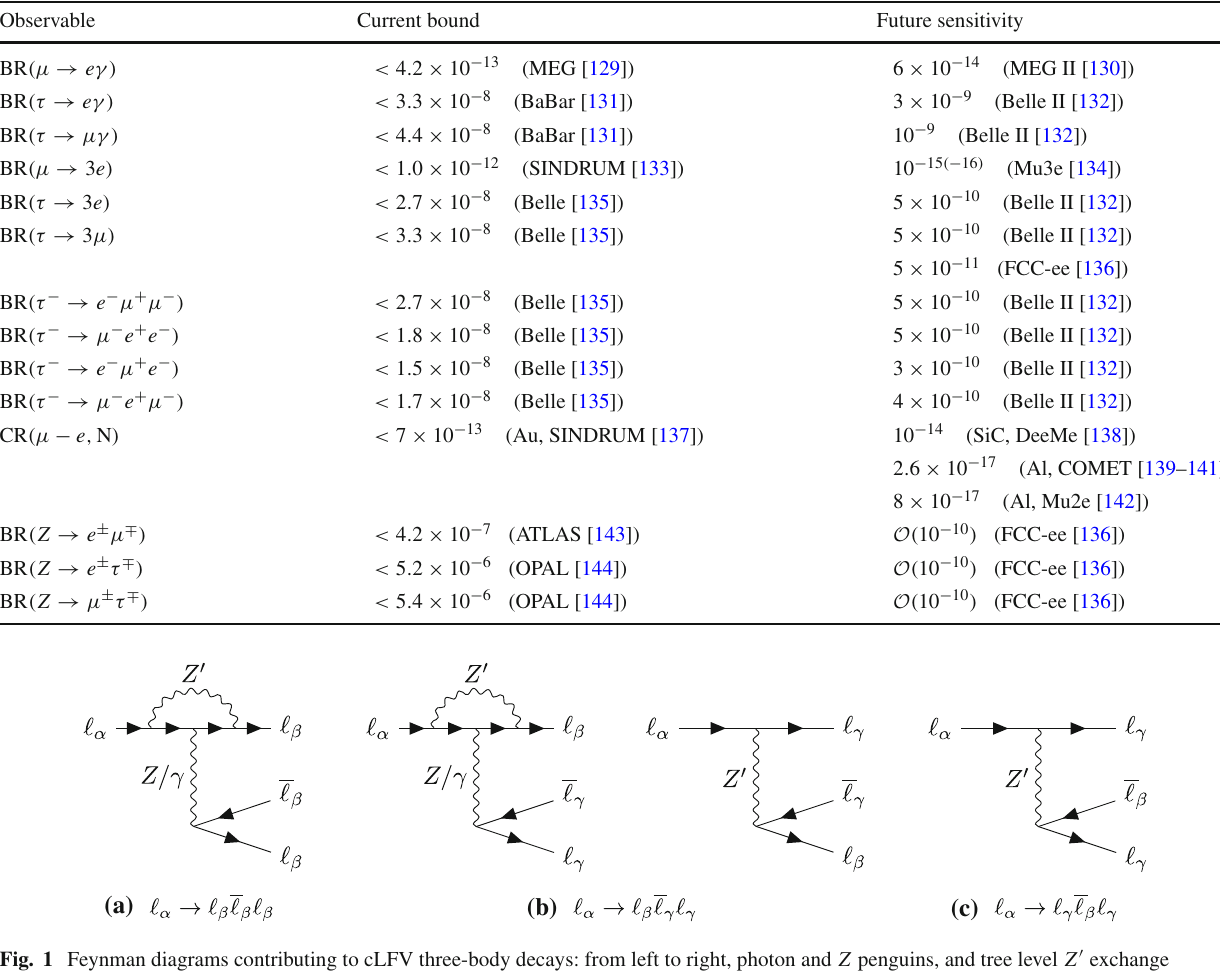
Fig. 1 Feynman diagrams contributing to cLFV three-body decays: from left to right, photon and Z penguins, and tree level Z (cid:2) exchange inwhich (cid:4) i is theinternal lepton( (cid:4) i (cid:6)= (cid:4) α , (cid:4) β ), x i = m 2 and the right-handed (RH) coefficients are given by the exchange ( L ↔ R ) . The divergence (cid:2) ε